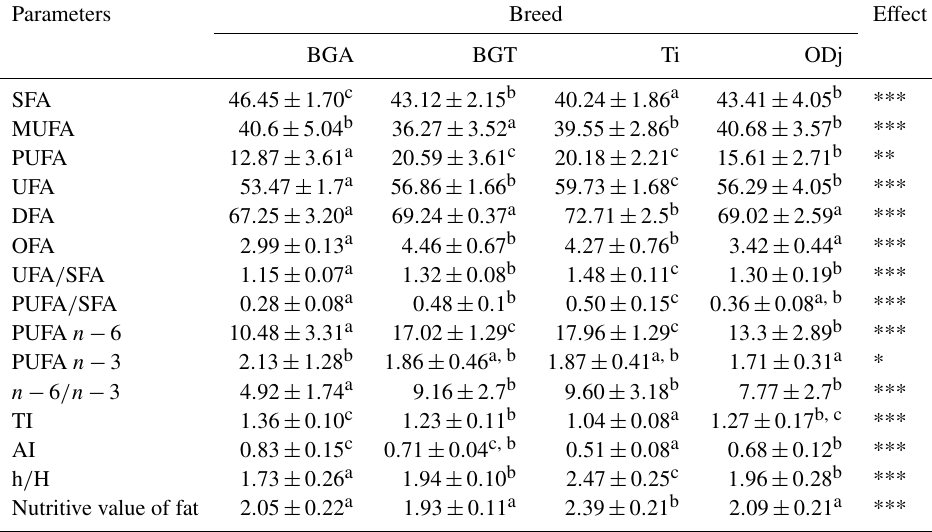
Table 3. Partial sums of fatty acids (g per 100g fatty acids), ratios, and indices of Beni Guil (BG), Timahdite (Ti), and Ouled Djellal (ODj) sheep meats from Moroccan